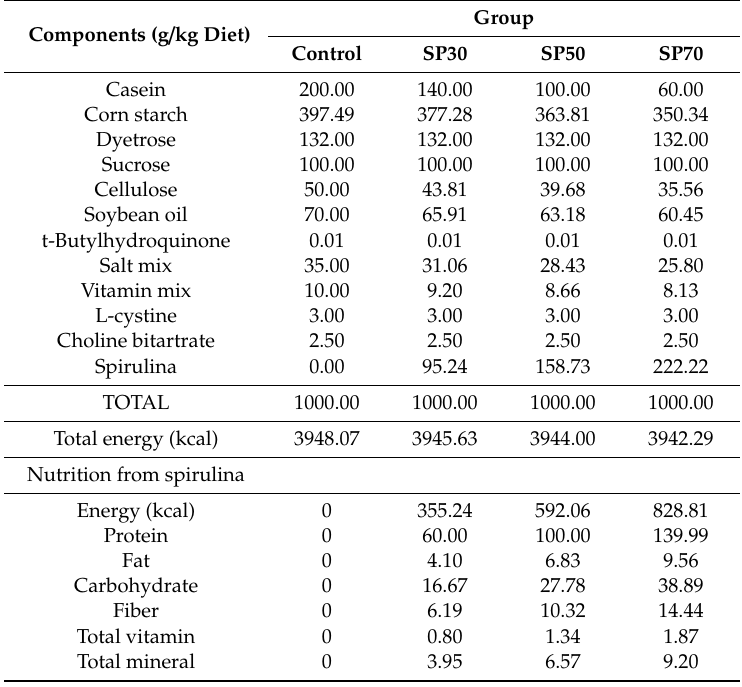
Table 3. Composition of experimental